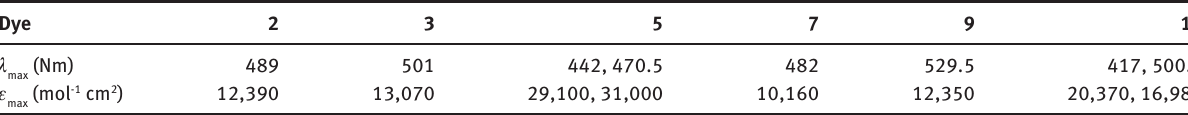
Table 1: Absorption spectra of the monomethine cyanine dyes in absolute ethanol. Dye